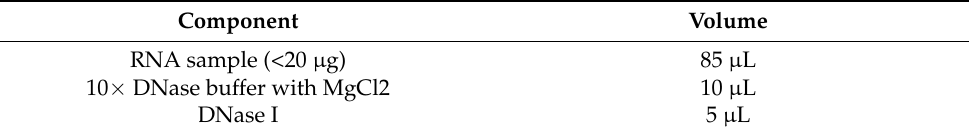
Table 2. DNA removal reaction mix.